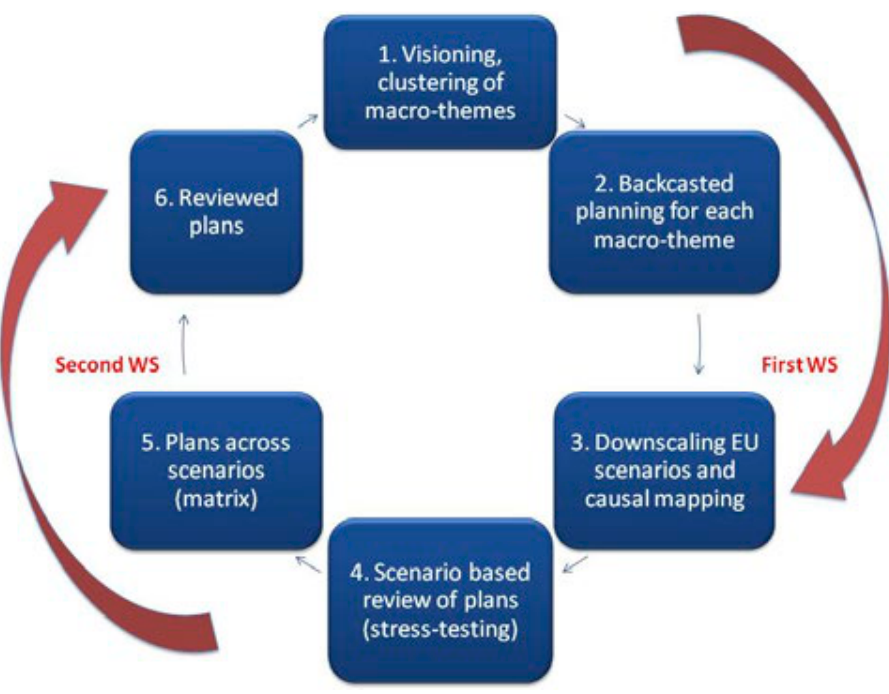
Figure 2. Building blocks of the two